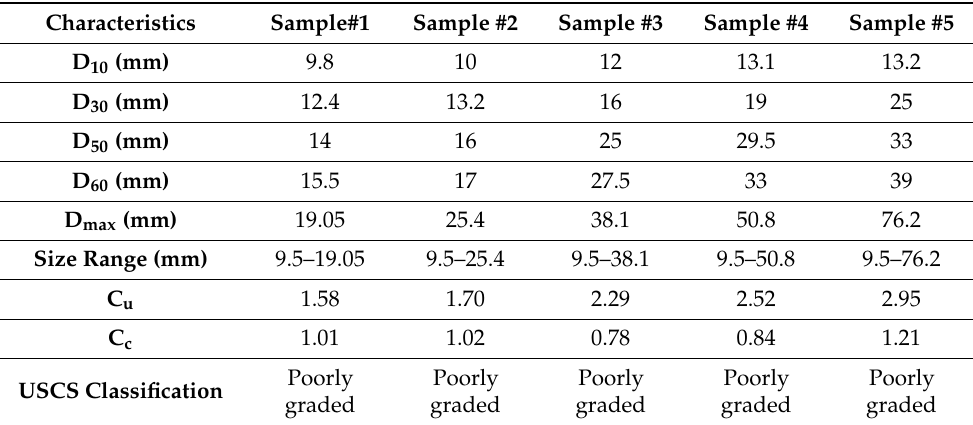
Table 1. Characteristics of the TDA used in the